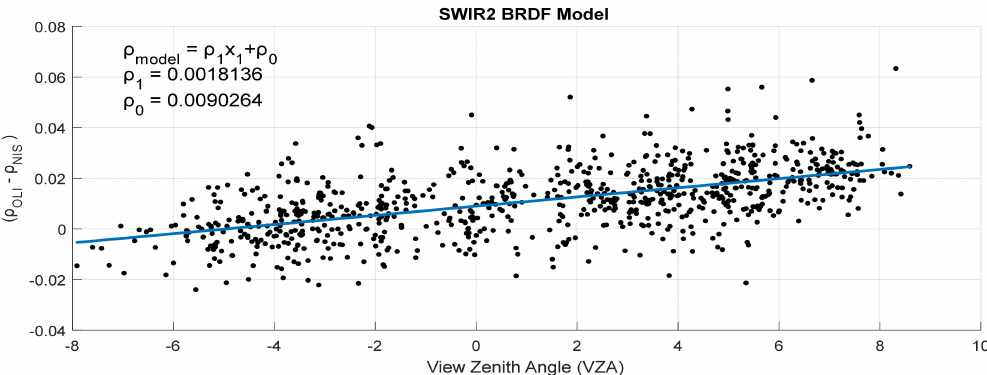
Figure 14. NIS bidirectional reflectance distribution function (BRDF) reflectance di ff erence